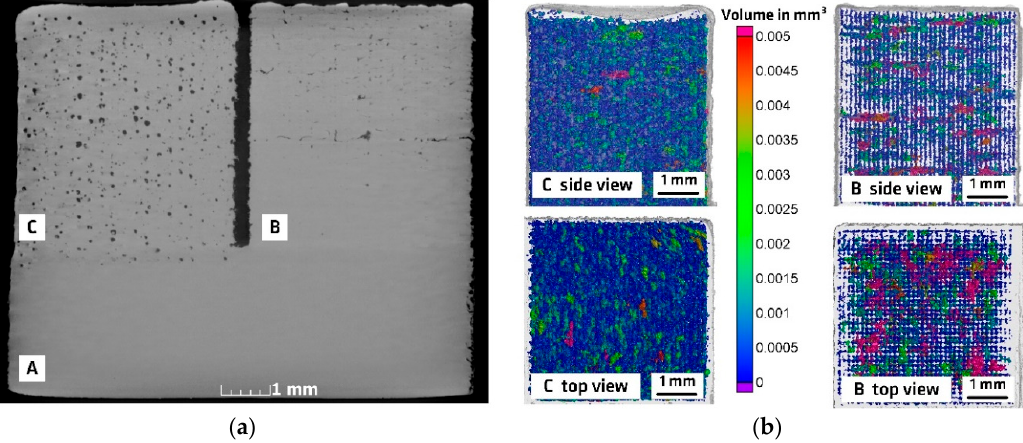
Figure 5. µCT images with achieved voxel size of 7.12 µm. ( a ) µCT cross section of the specimen. ( b ) Figure 5. µ CT images with achieved voxel size of 7.12 µ m. ( a ) µ CT cross section of the specimen. Visualization of porosity according to their volume. ( b ) Visualization of porosity according to their